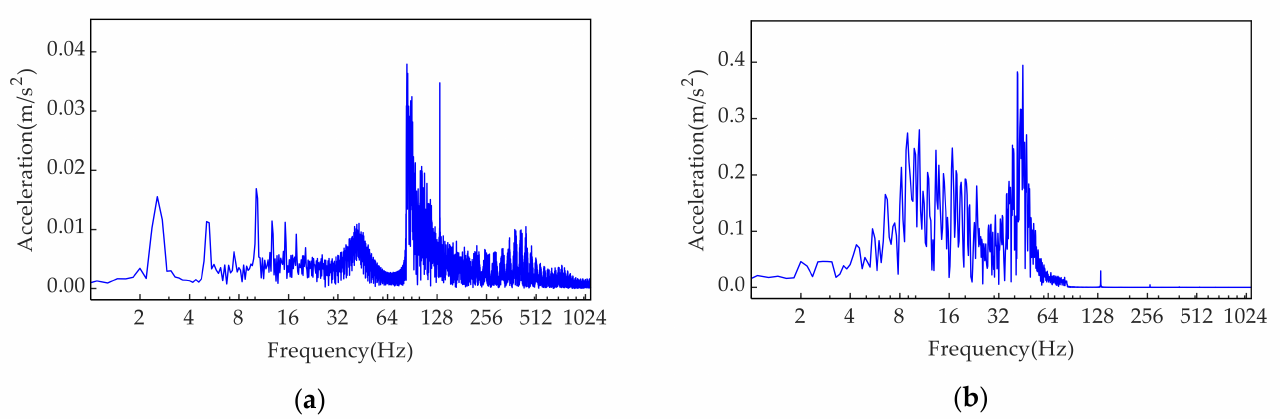
Figure 15. Frequency distribution of the vertical acceleration of the bogie under: ( a ) track short wave irregularity; ( b ) track medium-long wave irregularity.